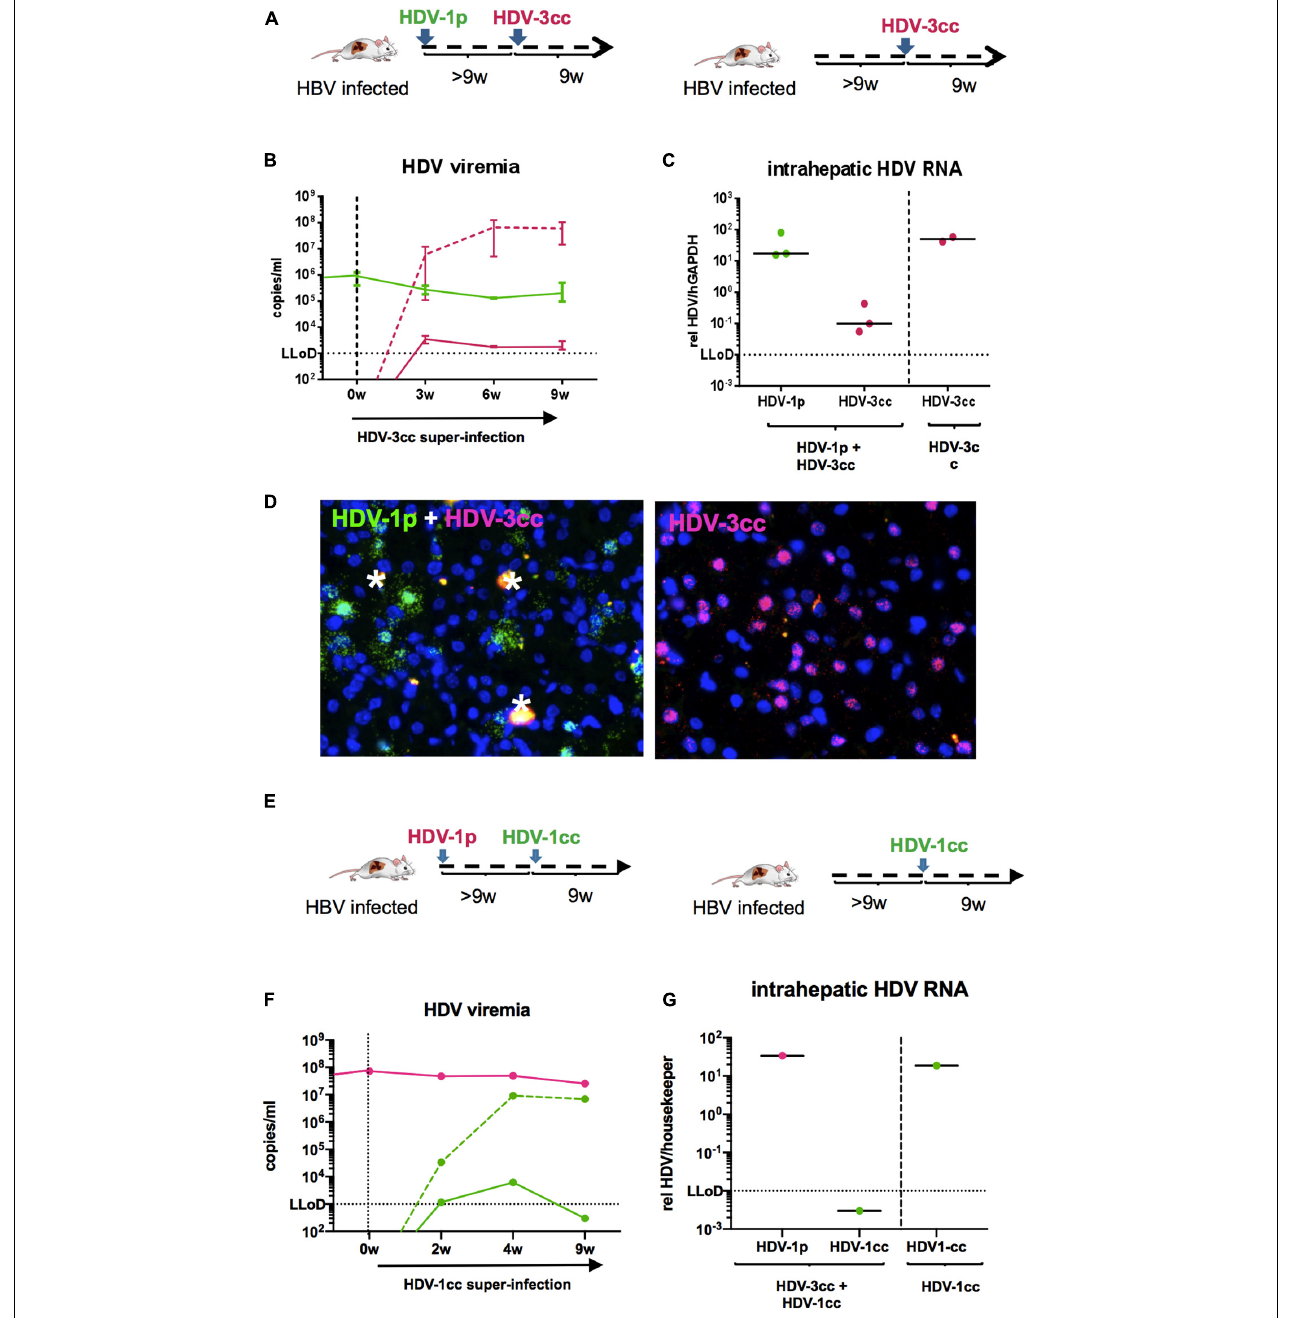
FIGURE 6 | HDV in chronic HBV-infected mice sequentially super-infected with HDV-1p and HDV-3cc, or HDV-1p and HDV-1cc. (A) Experimental setting (first HDV-1p, then HDV-3cc; control mice were super-infected with HDV-3cc only). (B,C) qRT-PCR measurements (genotype specific HDV primers/probe for HDV-1 and HDV-3 were used) of serum HDV RNA (quantification with cell culture derived RNA standard) at different time-points (B) and liver HDV RNA (normalized to housekeeping gene hGAPDH) at the end of experiment (C) . HDV-1p RNA levels are depicted in green (line or dots) and HDV-3cc RNA levels in red (line or dots). The dashed red line shows HDV viremia in control mice (HDV-3cc only). Results are expressed as median ± range (B) , the bar shows median levels (C) . (D) RNA in situ hybridization (RNAScope) staining of HDV-1p (green) and HDV-3cc AG HDV RNA (red) in HDV-1p/HDV-3cc sequential super-infected ( left ) and HDV-3cc control mice ( right ) at the end of the experiment. Nuclei are stained with dapi (blue). Phagocytic remnants have an autofluorescence and are marked with a white star. (E) Experimental setting (first HDV-1p, then HDV-1cc; control mouse was super-infected with HDV-1cc only). (F,G) qRT-PCR measurements (strain specific HDV primers/probe for HDV-1cc and HDV-1p were used) of serum HDV RNA (quantification with cell culture derived RNA standard) at different time-points (F) and liver HDV RNA (normalized to housekeeping gene hGAPDH) at the end of experiment (G) . HDV-1p RNA levels are depicted in red (line or dots) and HDV-1cc RNA levels in green (line or dots). The dashed green line shows HDV viremia in control mouse (HDV-1cc only).